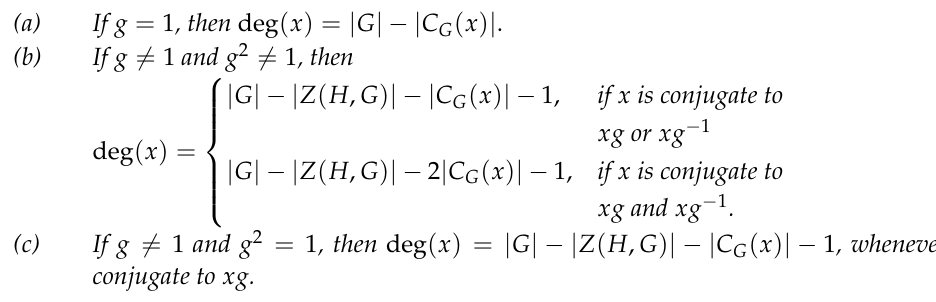
Figure 6. ∆ bab 2 2 H 3 , A 4 H 3 , A 4